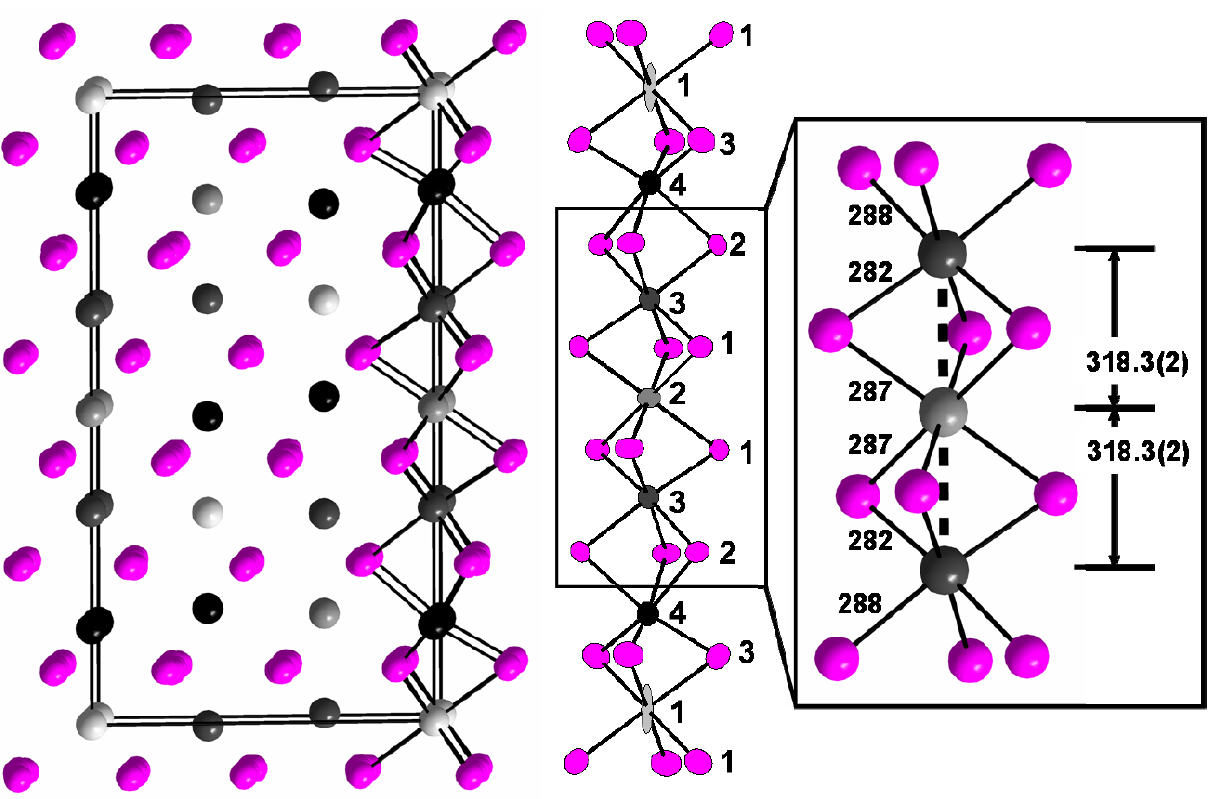
Figure 1. Projection of the crystal structure of Hf column of face-sharing octahedra as the repeat unit along [001] in Hf ellipsoids are at a 90% probability level) and a cut-out of the trimer with relevant distances (in pm,